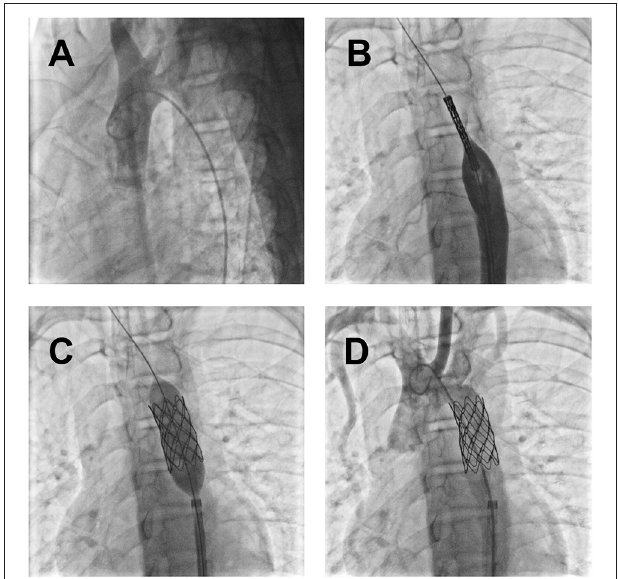
FIGURE 3 | Coarctation intervention with the guidance of digital subtraction angiography: (A) The coarctated descending aorta was confirmed by the poor perfusion of the iodine contrast medium to the distal segment; (B) inserted endovascular stent; (C) balloon dilatation and endovascular stent